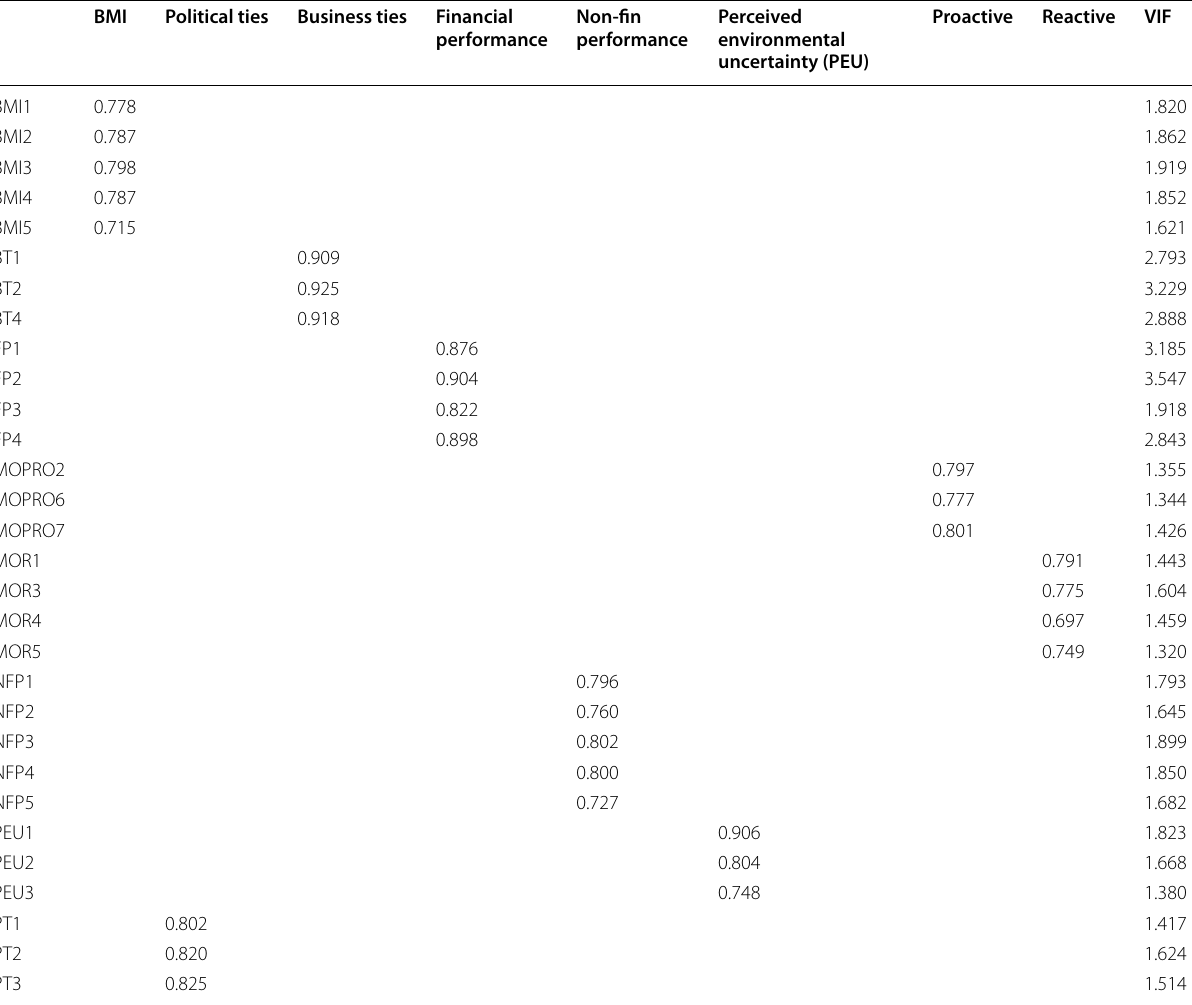
Table 2 Variables loadings,